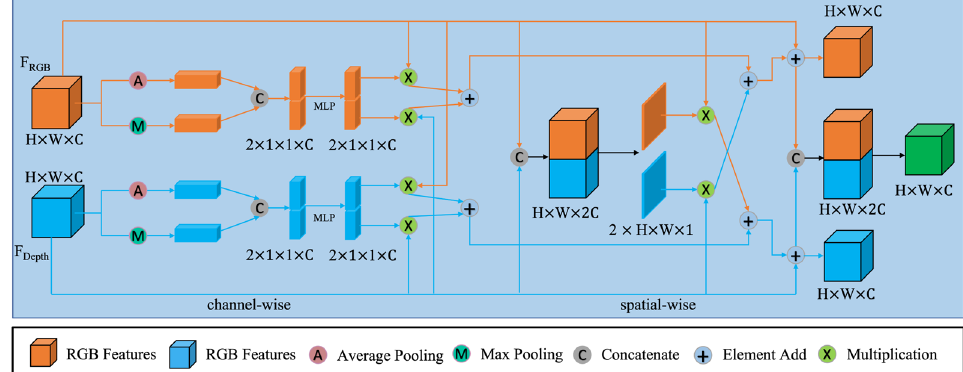
Figure 3. CMFFM structure.